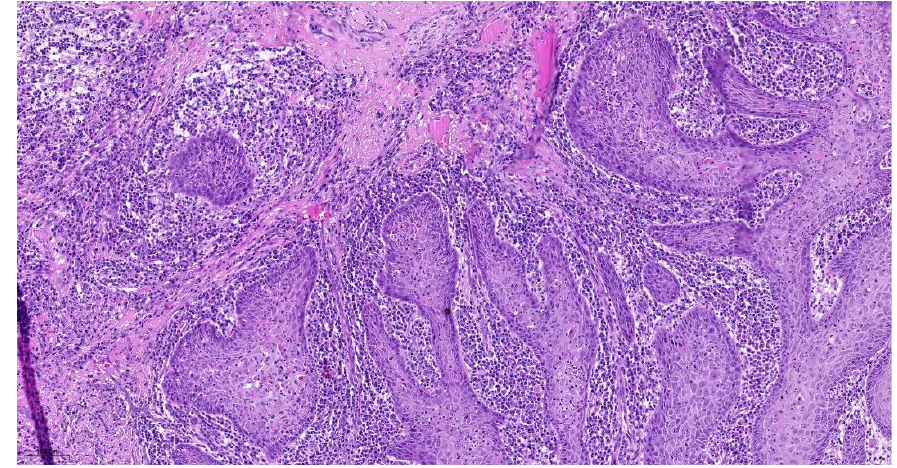
Figure 1. CNS(1) + TB(1) = CDG-1 _10.0×.